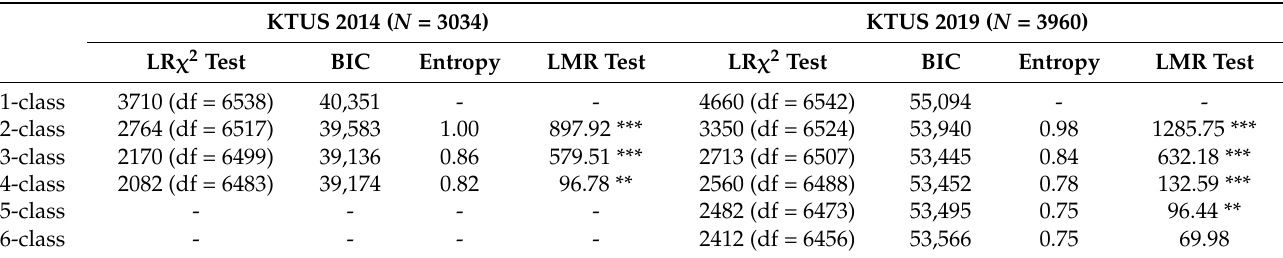
Table 2. Model fit statistics for LCA for male and female older